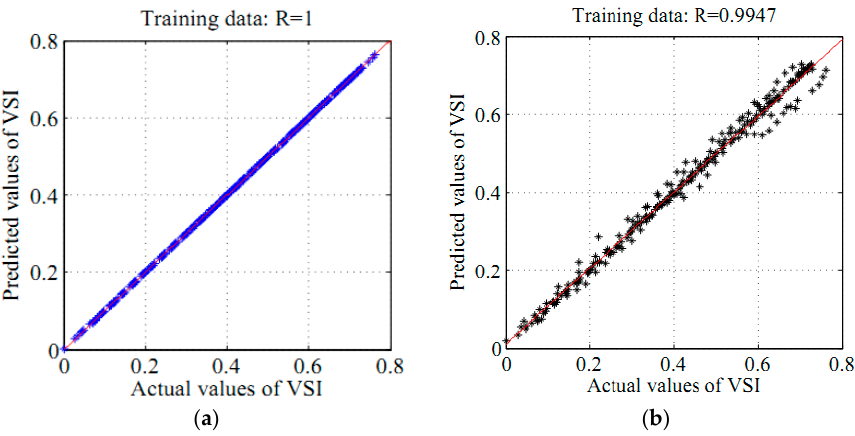
Figure 5. Linear fits between the actual and predicted VSI for IEEE 30-bus in training phase using ( a ) ALO-SVR; ( b ) ANFIS.